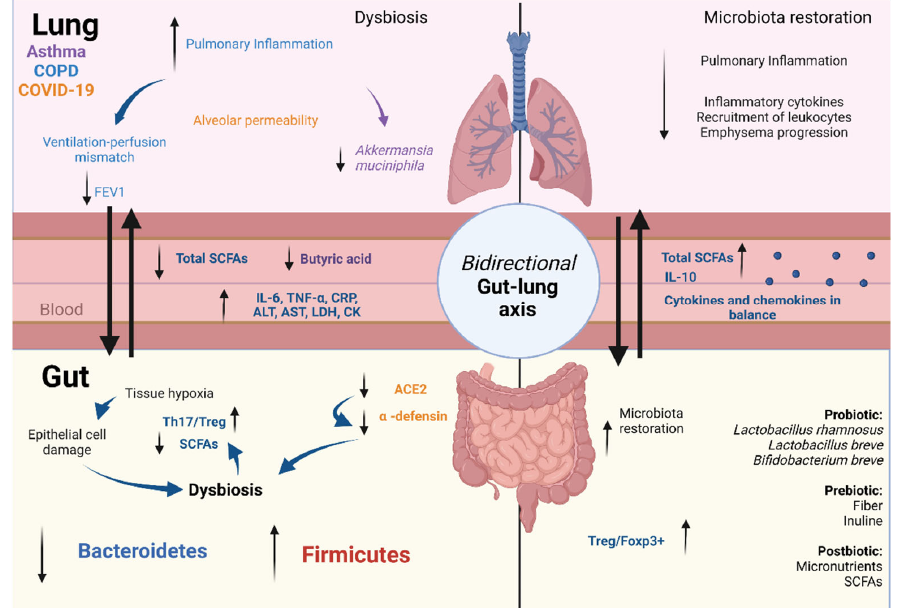
Figure 3. Microbiota–gut–lung axis. The microbiota–gut–lung communication is bidirectional, through the lymph and blood circulation, being conducted by metabolites released in both mucous membrane tissues. The presence of intestinal dysbiosis during lung disease plays a key role through its immunomodulatory capacity. In COPD, ventilation–perfusion mismatch leads to intestinal tissue hypoxia and epithelial cell damage associated with dysbiosis, which induces a decrease in SCFA secretion, an increase in the Th17/Treg ratio, and the secretion of proinflammatory cytokines, which correlates with pulmonary inflammation. In asthma, intestinal dysbiosis correlates positively with disease severity. The decrease in A. muciniphila and increase in the alveolar epithelium permeability are associated with a decrease in Bacteroides acidifaciens and butyric acid concentration. In COVID-19, SARS-CoV-2 decreases the ACE2 expression in the gut, which is associated with gut dysbiosis, with an increase in pathogens and a decrease in probiotic bacteria. This leads to an increase in intestinal permeability, proinflammatory markers, neutrophil recruitment, and cell activation in the pulmonary tissue. Prebiotic, probiotic, and postbiotic supplementation restores GM, reduces inflammation in the airways, restores the balance between cytokine and chemokine production, decreases leucocyte recruitment, and increases the SCFA concentration: COPD, chronic obstructive pulmonary disease; SCFAs, short-chain fatty acids; COVID-19, coronavirus disease 2019; FEV1, forced expiratory volume in the first second; ALT, alanine transaminase; AST, aspartate transaminase; LDH, lactate dehydrogenase; CK, creatine kinase; Treg, regulatory T lymphocyte. Created with